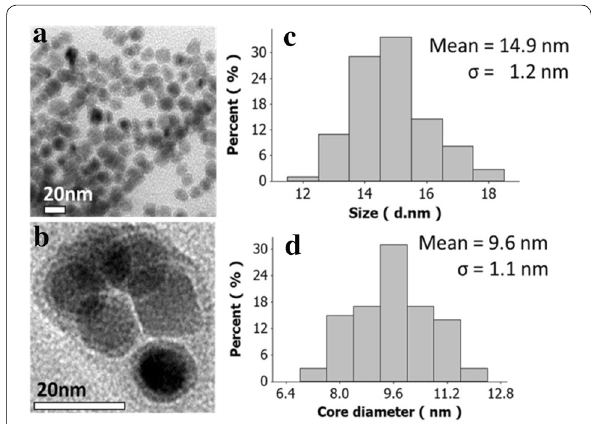
Fig. 1 a Low and b relatively high magnification TEM images of the synthesized Fe@Fe 3 O 4 nanoparticles prepared via thermal decomposition of iron pentacarbonyl. Size histogram of c whole particles and d the iron core